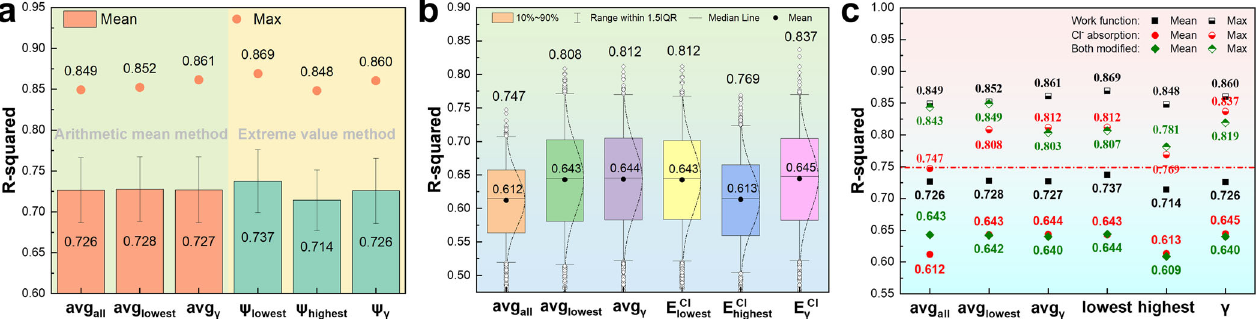
Fig. 7 Contrast of different statistical strategies for calculation modi fi ed corrosion dataset. a Mean accuracy and optimal strategies using WF. b Statistics of model accuracy after supplementation with the Cl AE. c Average and maximum accuracy comparison of models with a single factor (WF or Cl AE) or both the